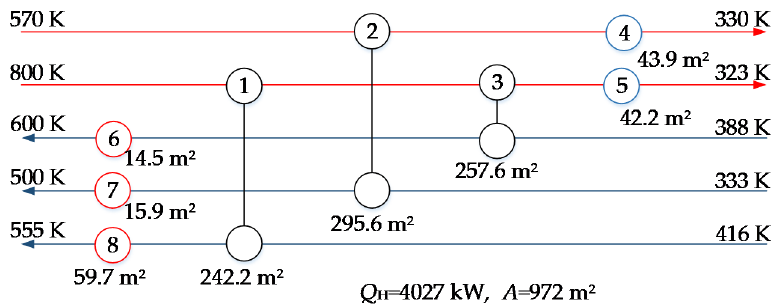
Figure 9. Optimal network of heat exchangers determined by multi-scenario stochastic approach (different time